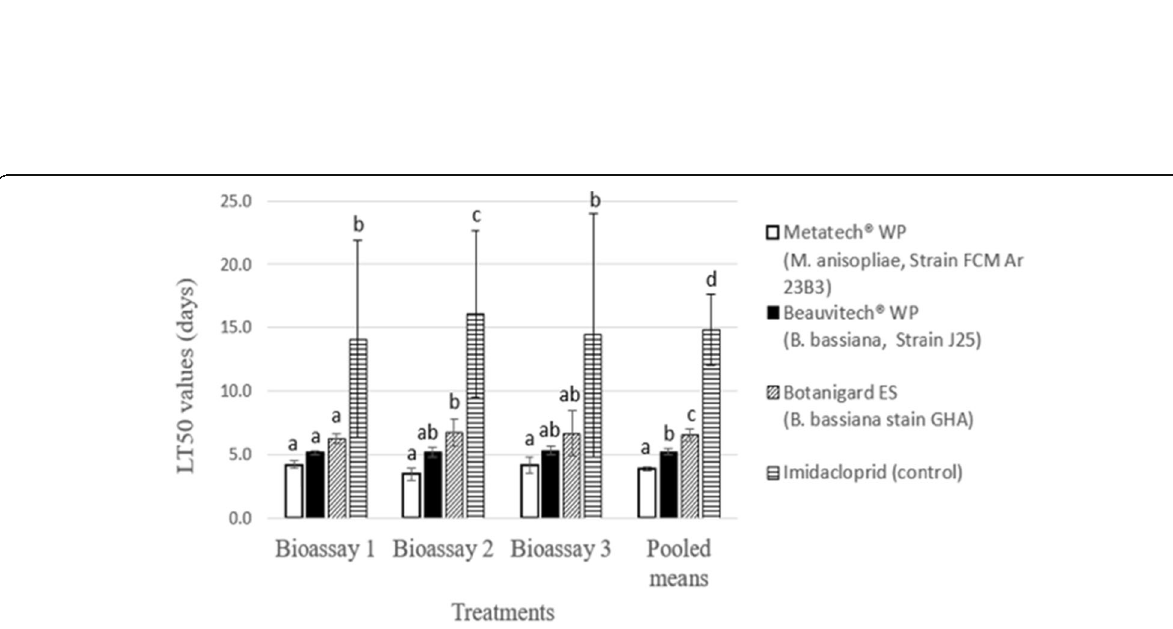
Fig. 2 Lethal time in days to control 50% of Tuta absoluta larvae treated with commercial EPF formulations (10 8 spores ml − 1 ) and imidacloprid (1mlL − 1 ). Different letters above the means +SD bars indicate significant difference within the same bioassay according to Tukey test ( p